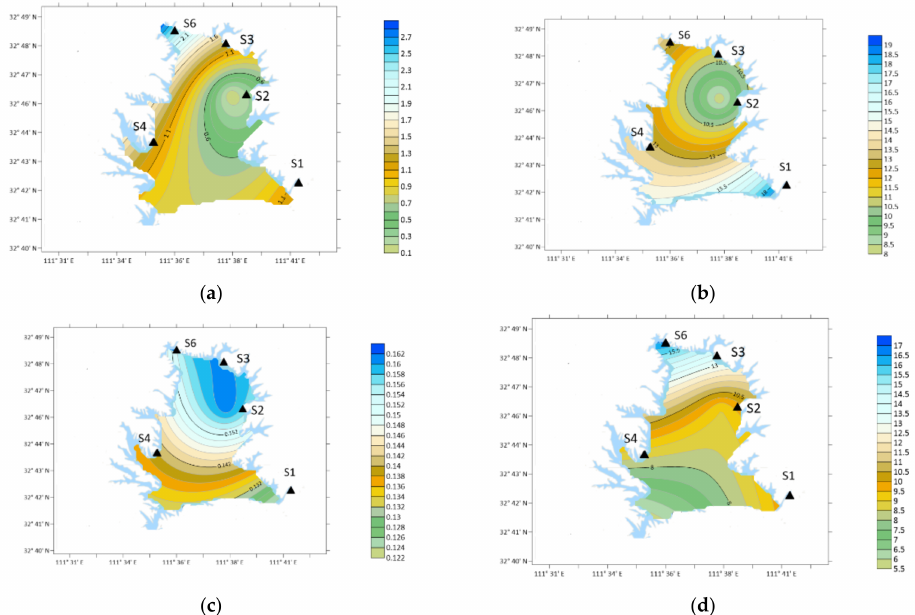
Figure 6. Spatial variation of DMA concentration. ( a ) Winter; ( b ) spring; ( c ) summer; ( d ) autumn.